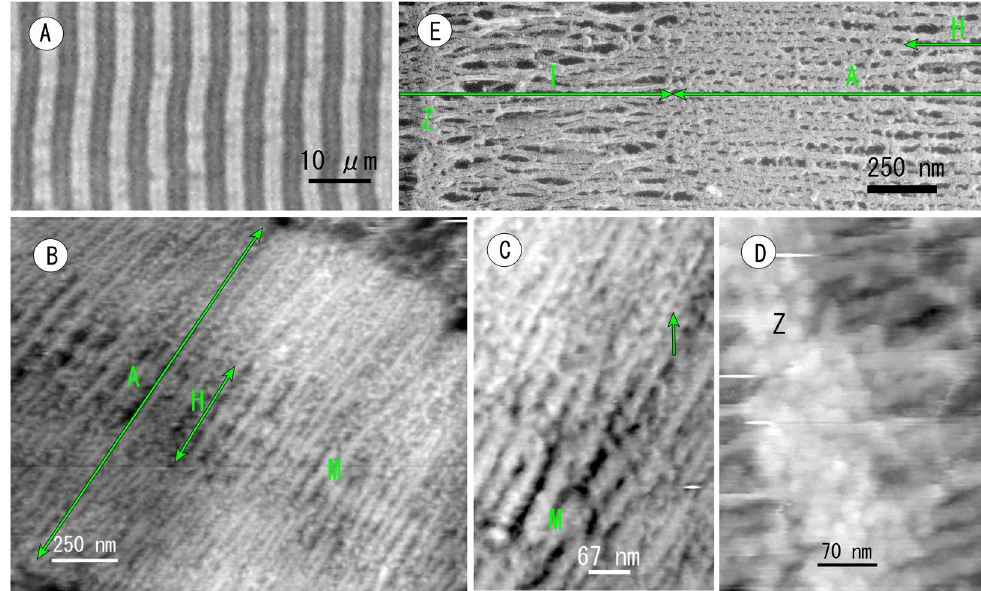
Figure 6. Atomic force micrograph of the cryosection of a rabbit psoas muscle. ( A ) Phase contrast light microscopic image of cryosections placed on a glass slide and soaked in PBS. Striations consisting of the anisotropic band and isotropic band were found. ( B ) AFM images of the anisotropic band in a sarcomere (a part of A ) showing the interaction between thin (actin) and thick (myosin) filaments clearly. ( C ) High power AFM image of the anisotropic band showing thick filaments swelled in the centre of the H zone (M-line) and cross bridges (an arrow) between thin and thick filaments. ( D ) High magnification image of the Z-disk showing attachment of actin filaments. The main feature of the Z-disk remains ambiguous. ( E ) A freeze-etching EM image for reference. Half-length of a sarcomere is depicted. Z: Z-disk; I: isotropic band; A: anisotropic